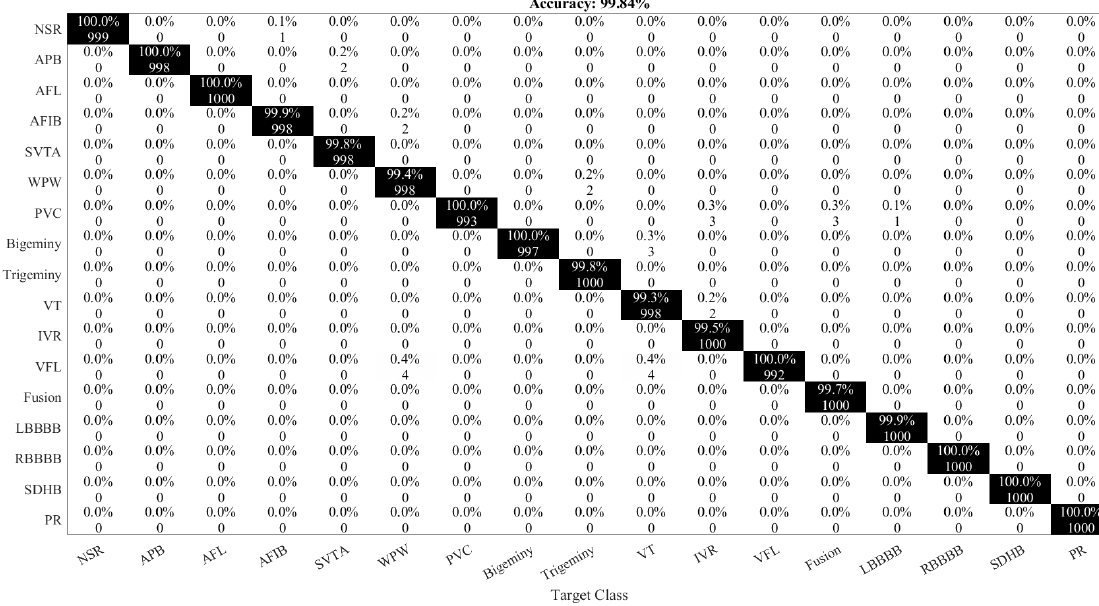
Figure 10. Confusion matrix of the ArrhythmiaNet with SVM classifier.